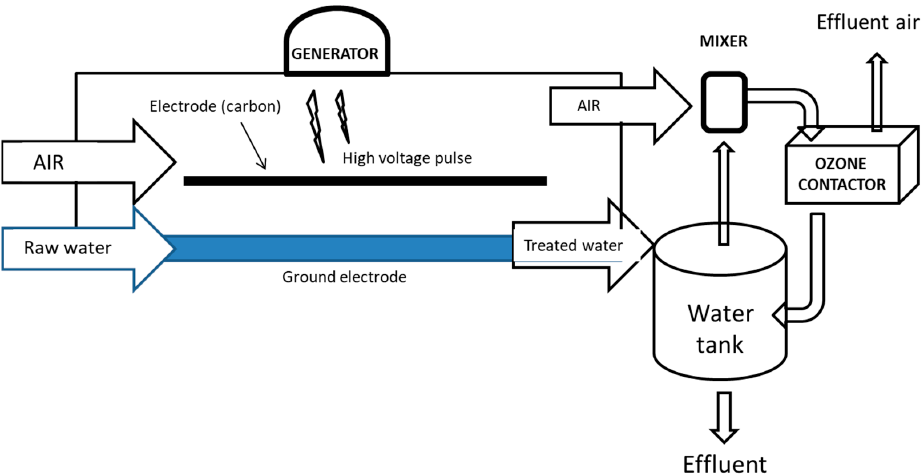
Figure 2. Schematics of a NTP unit. non-thermal plasma (NTP).